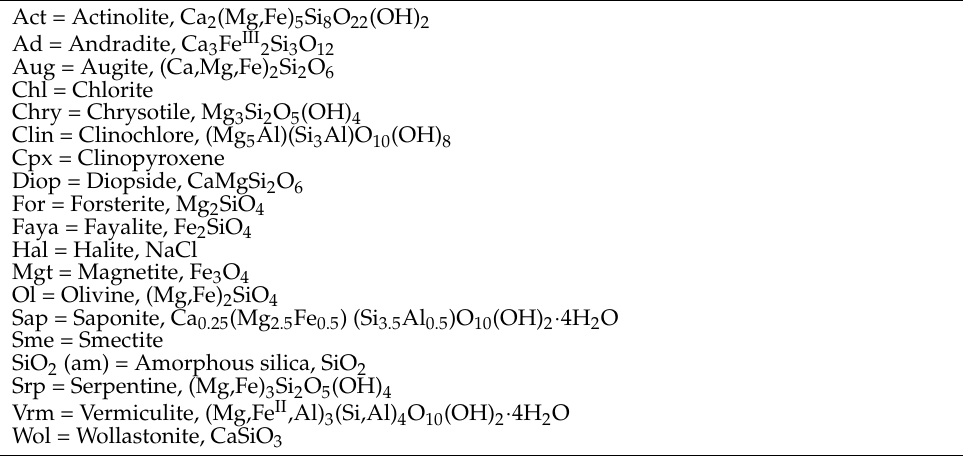
Table A1. Abbreviations and compositions used in this